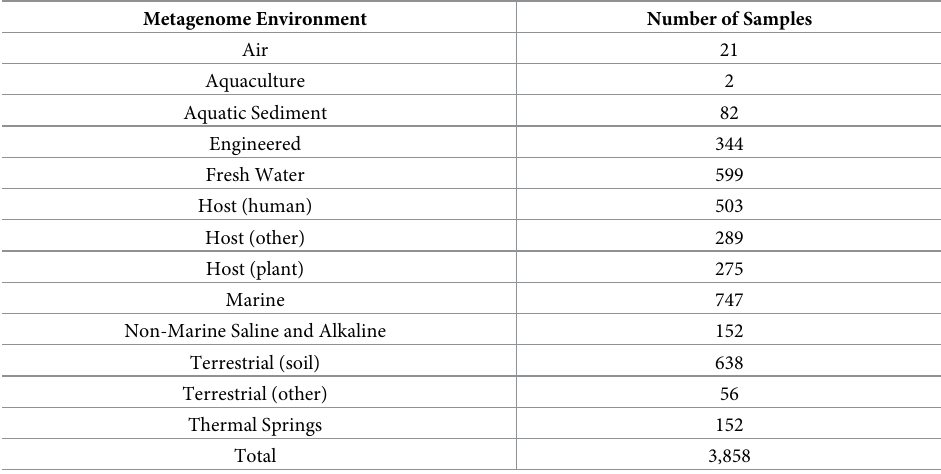
Table 1. Metagenomic datasets classified by habitat